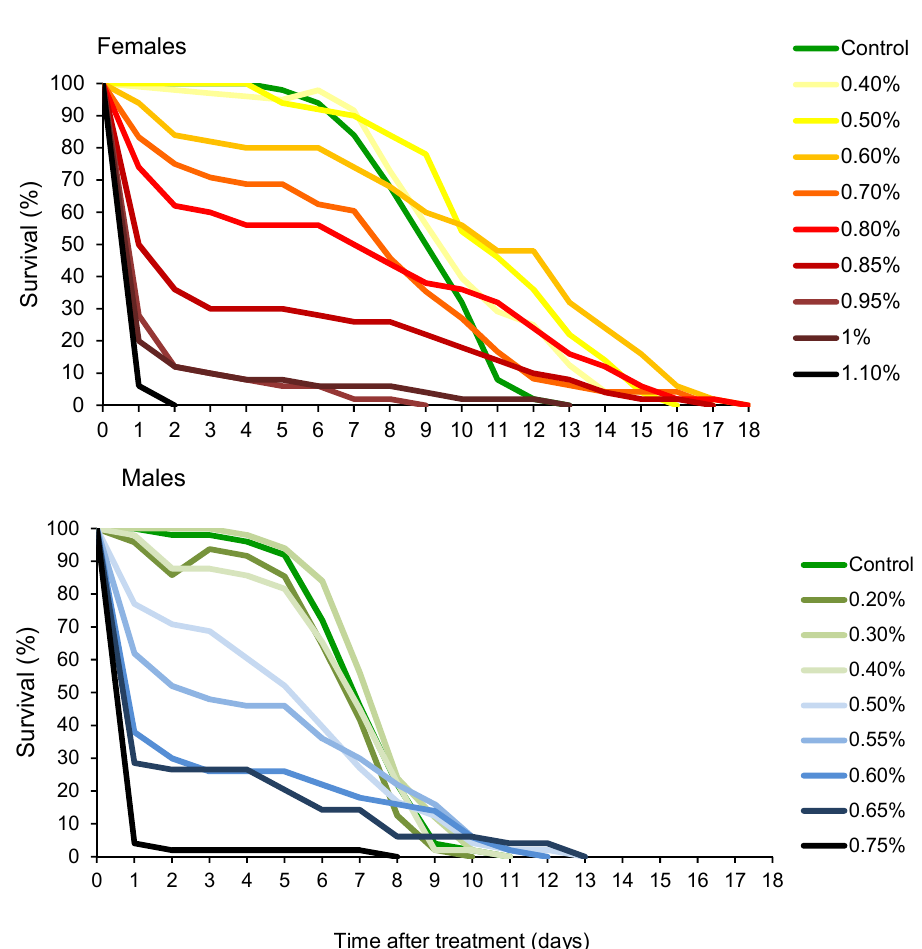
Figure 2. Changes in percentage of survival over time for Acanthoscelides obtectus females and males exposed to different concentrations of thyme oil. Table 2. Effects of different concentrations of thyme essential oil (EO) on Gompertz mortality parameters a and b . Baseline mortality ( a ) and exponential increase in mortality with age ( b ) are presented with 95% confidence intervals (CI). Significant differences from the control group are marked with asterisks (log-likelihood ratio test, df = 1, p < 0.05).